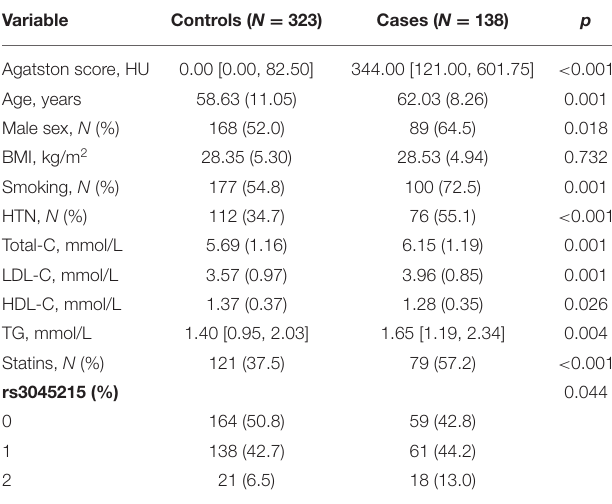
TABLE 1 | Clinical characteristics of OHGS CT angiography samples with Agatston scores genotyped for rs3045215.